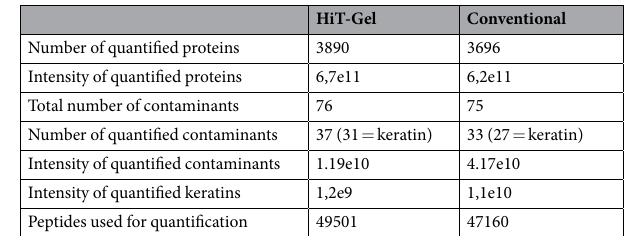
Table 1. Comparison of the HiT-Gel and conventional method on a complex protein sample. The two datasets obtained from the plant extracts separated by SDS-PAGE were compared in terms of quantified peptides, proteins and contaminants. Signal intensities are also reported for the quantified proteins and contaminants. Protein identification was performed in Mascot (No protein grouping, unique peptides only, 1% FDR, Mascot ion score > 25) before being reimported into Progenesis